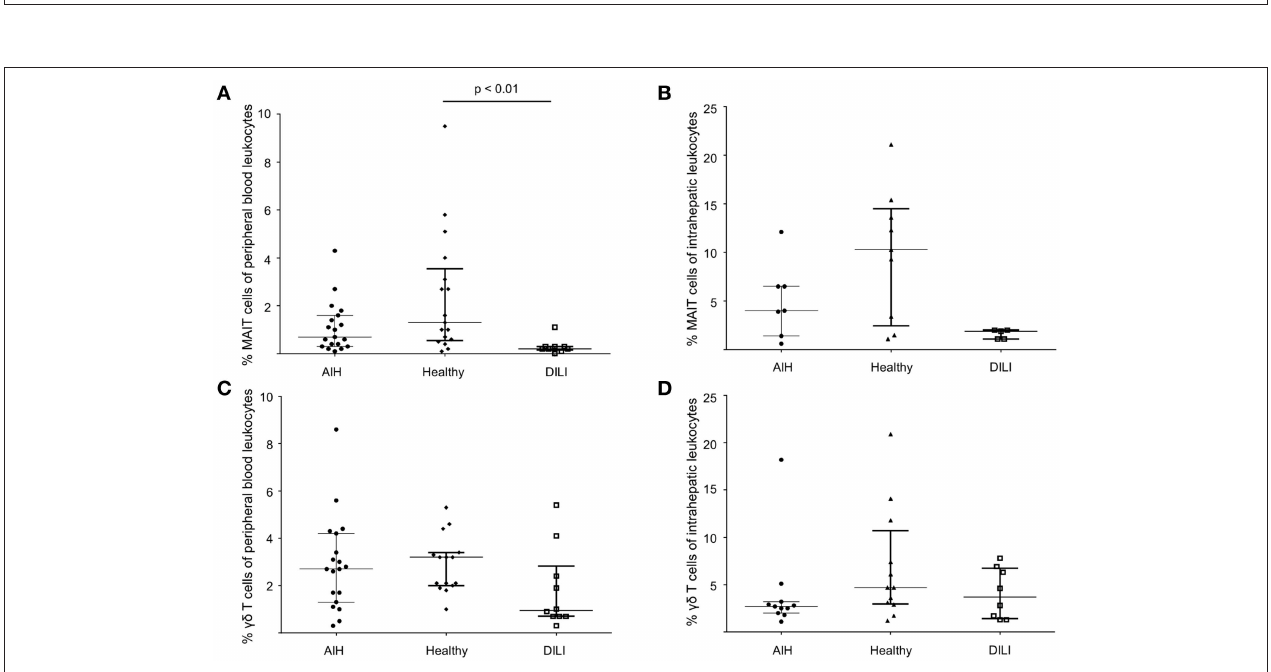
FIGURE 5 | No increased infrequency of peripheral blood and intrahepatic MAIT cells or γδ T cells in AIH patients. To exclude unspecific elevation of type II NKT in AIH patients, peripheral blood and intrahepatic MAIT cells (A,B) and peripheral blood and intrahepatic γδ T cells (C,D) were also quantified by flow cytometry revealing no increased infrequency of peripheral blood and intrahepatic MAIT cells or γδ T cells in AIH patients compared to healthy subjects or DILI patients.